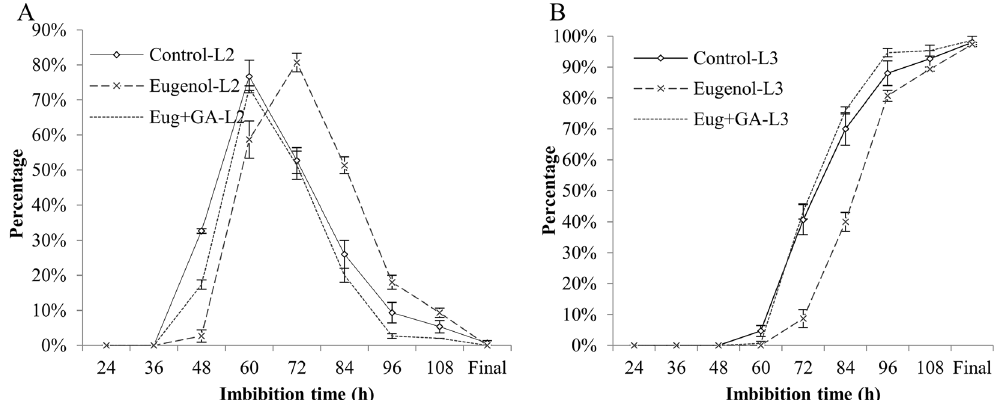
Figure 3. Effects of eugenol and eugenol-GA 3 combined treatment on the percentage of Level 2 ( A ) and Level 3 ( B ) seeds of Qian You 1. Control: seeds soaked in water; Eugenol: seeds soaked in 2.0 g · L − 1 of eugenol; Eug + GA: seeds soaked in 2.0 g · L − 1 of eugenol + 50 mg · L − 1 of GA 3 mixed solution. L2: the radicle had extended to less than half the length of the whole seed; L3: the radicle length had extended to more than half the length of the whole seed. The data were the means of three replications, and the standard deviation was indicated by bars.